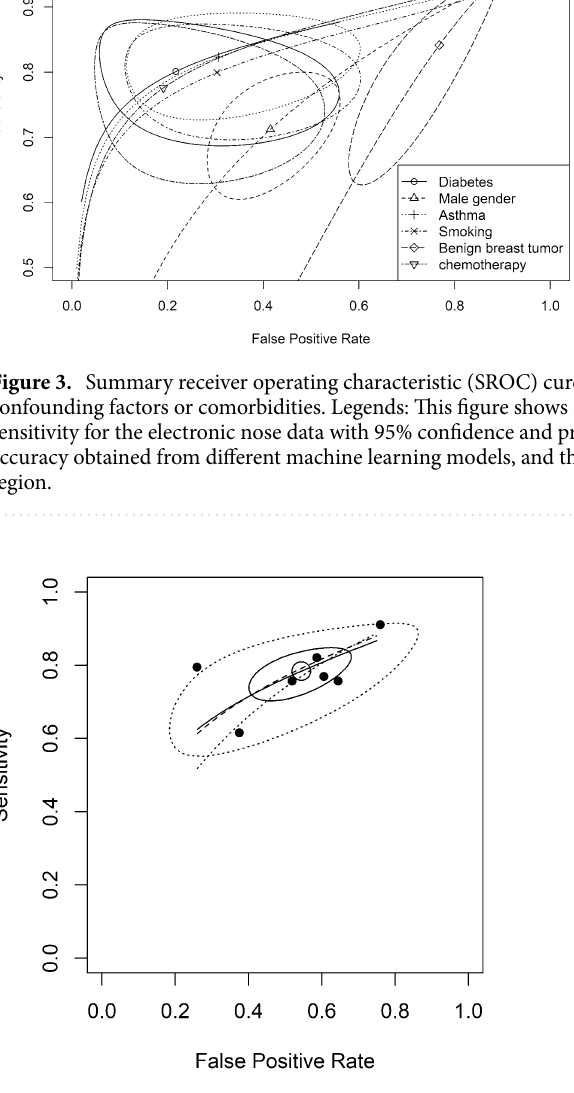
Figure 4. The joint estimate of false positive rate and sensitivity for the electronic nose data with 95% confidence and prediction regions. Legends: This figure shows the data that includes all study population without excluding any confounding factor or comorbidity. Scatter points are the data. A solid closed curve is the 95% confidence region. The dotted closed curve is the 95% prediction region. Three summary ROC curves are seen. The short solid line is the curve proposed by Rutter and Gatsonis 15 . The dashed line is the curve proposed by Moses et al. 16 ; the dotted line is the curve proposed by Rücker and Schumacher 17